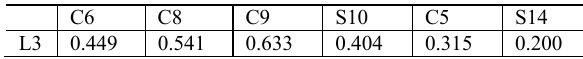
Table 4: Correlations: organisational learning and aspects of culture and